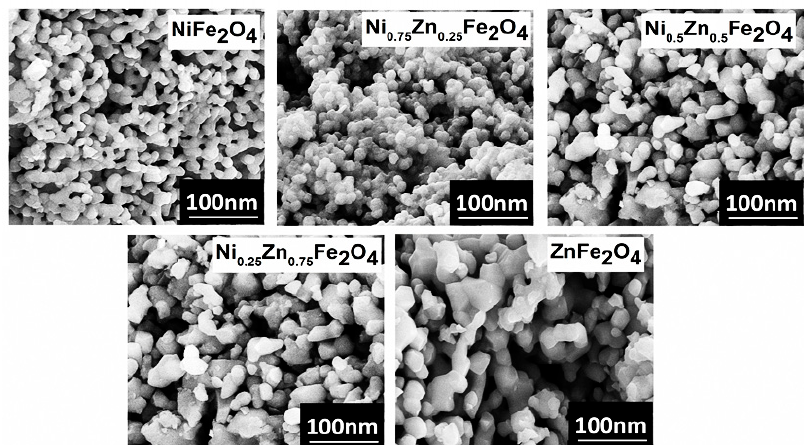
Figure 1. The SEM analysis for Ni 1-x Zn x Fe 2 O 4 (x = 0, 0.25, 0.5, 0.75, 1) nanoparticles with increasing zinc concentration.